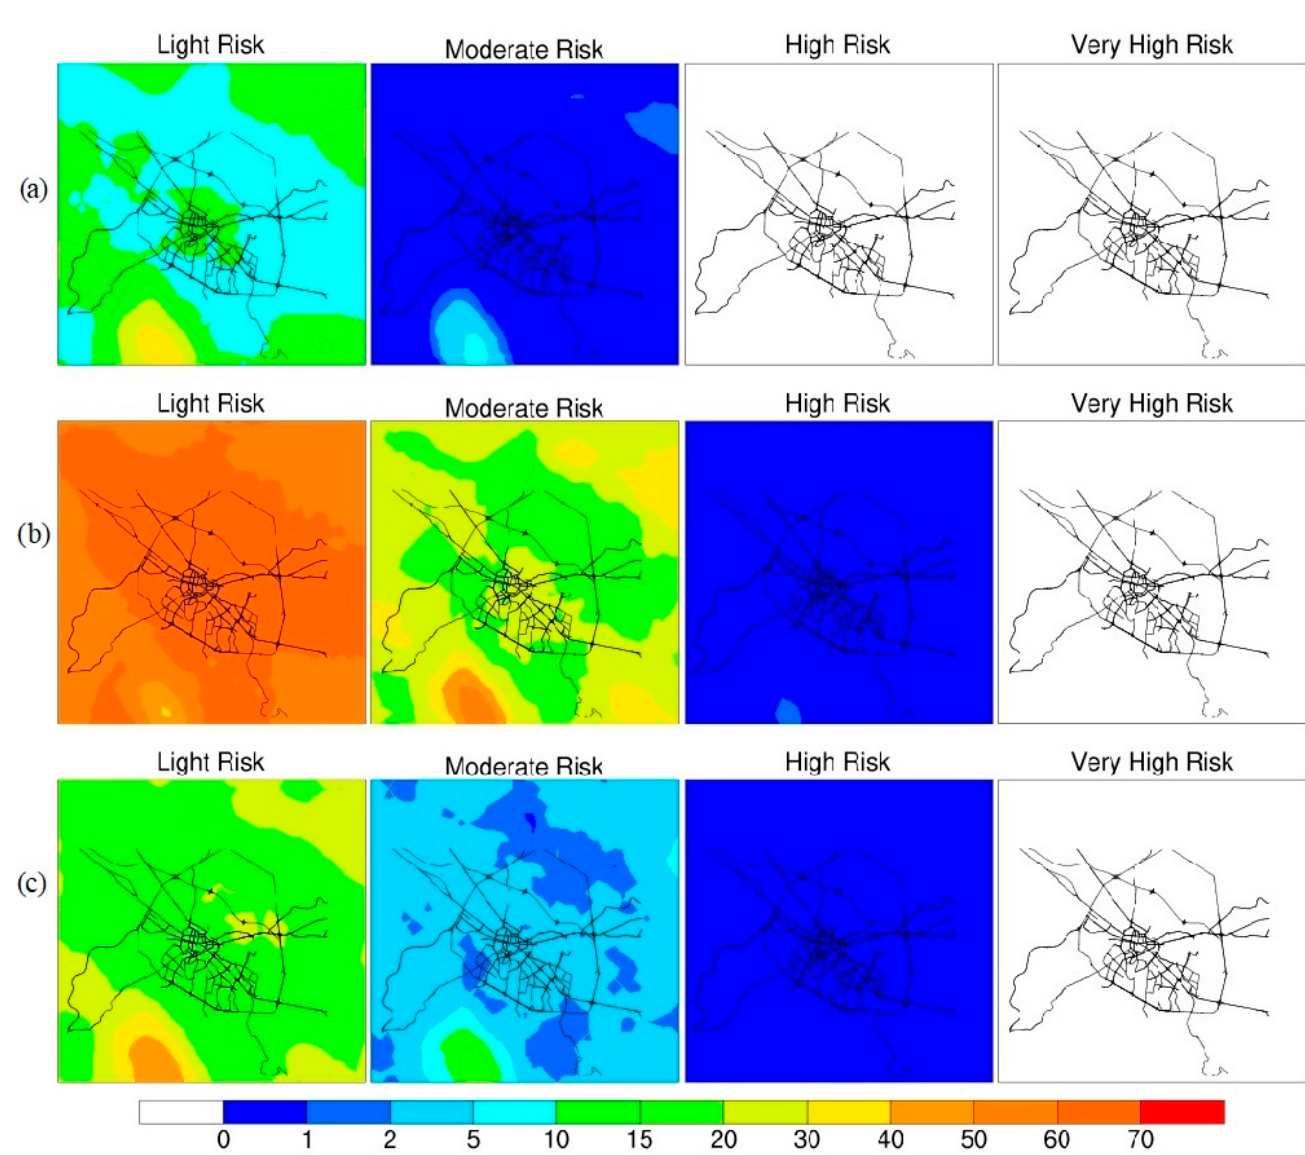
Figure 9. Frequency (in %) for ( a ) autumn, ( b ) winter, and ( c ) spring of the Wind-chill index categories “Low risk” (first column), “Moderate risk” (second column), and “High risk” (third column) in the Sofia region at 06 UTC during the autumn (first row), winter (second row), and spring (third row).